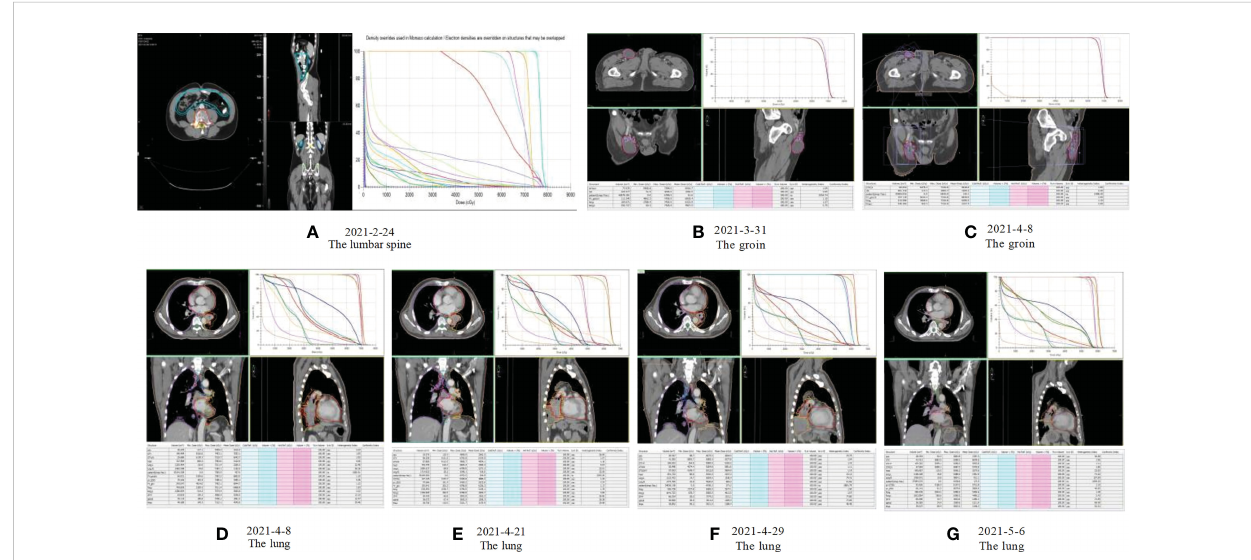
FIGURE 3 Radiotherapy plan: (A) Radiotherapy plan for the lumbar spine: Gross tumor volume (GTV L4-5) 35Gy/10F, Clinical target volume (CTV) 30Gy/10F; (B, C) Radiotherapy plan for inguinal metastatic lymph nodes: Gross tumor volume (GTVp) 52Gy/23F; (D-G) Radiotherapy plan for primary lung lesions: Gross tumor volume (GTVp) 47.6Gy/19F, Lymph node target volume (GTVn) 41.8Gy/19F.